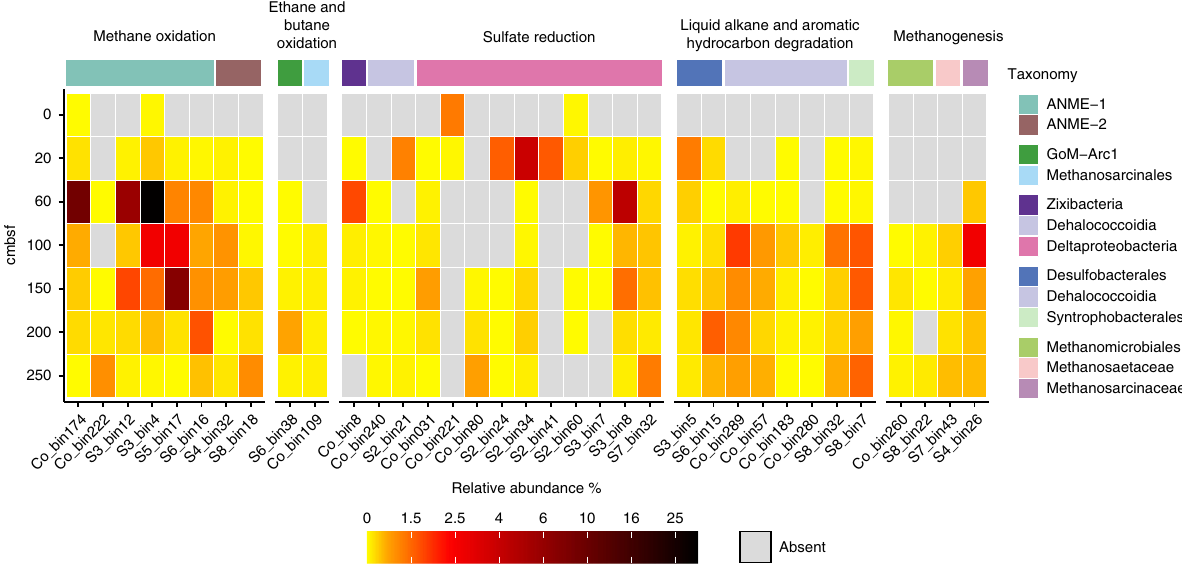
Fig. 7 Depth distributions of anaerobic hydrocarbon oxidizers and their potential partners inferred from metabolic pathway reconstructions. Species- level portrayal, with the MAG of highest genome quality from each species cluster being picked as the representative. Details on species clusters, relative abundances and replication rates of all microorganisms are presented in Supplementary Data